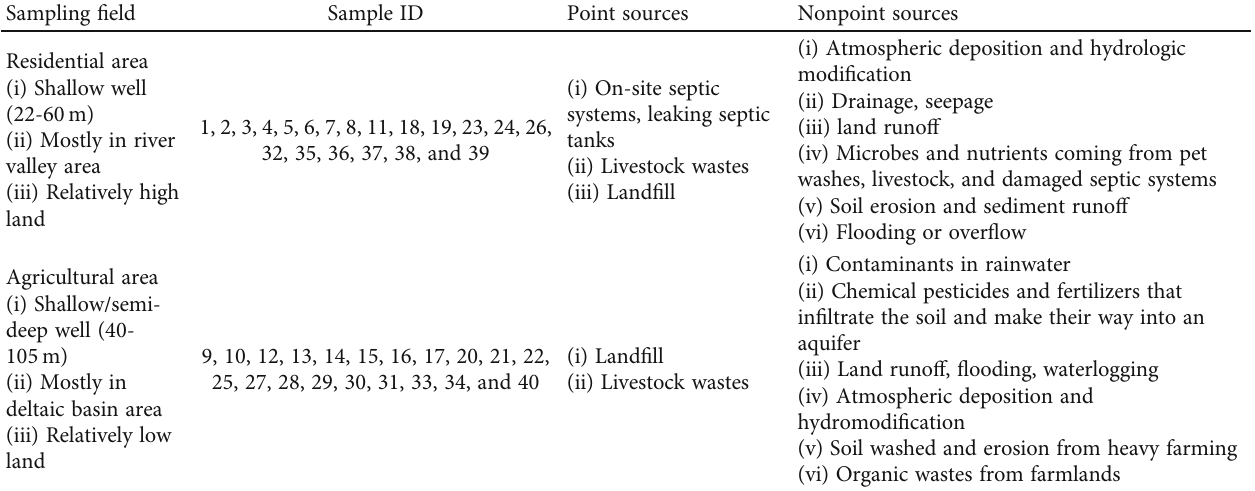
Figure 2: Lithological and hydrogeological formation of the study area. Table 1: Sampling descriptions and probable pollution sources of the sampling